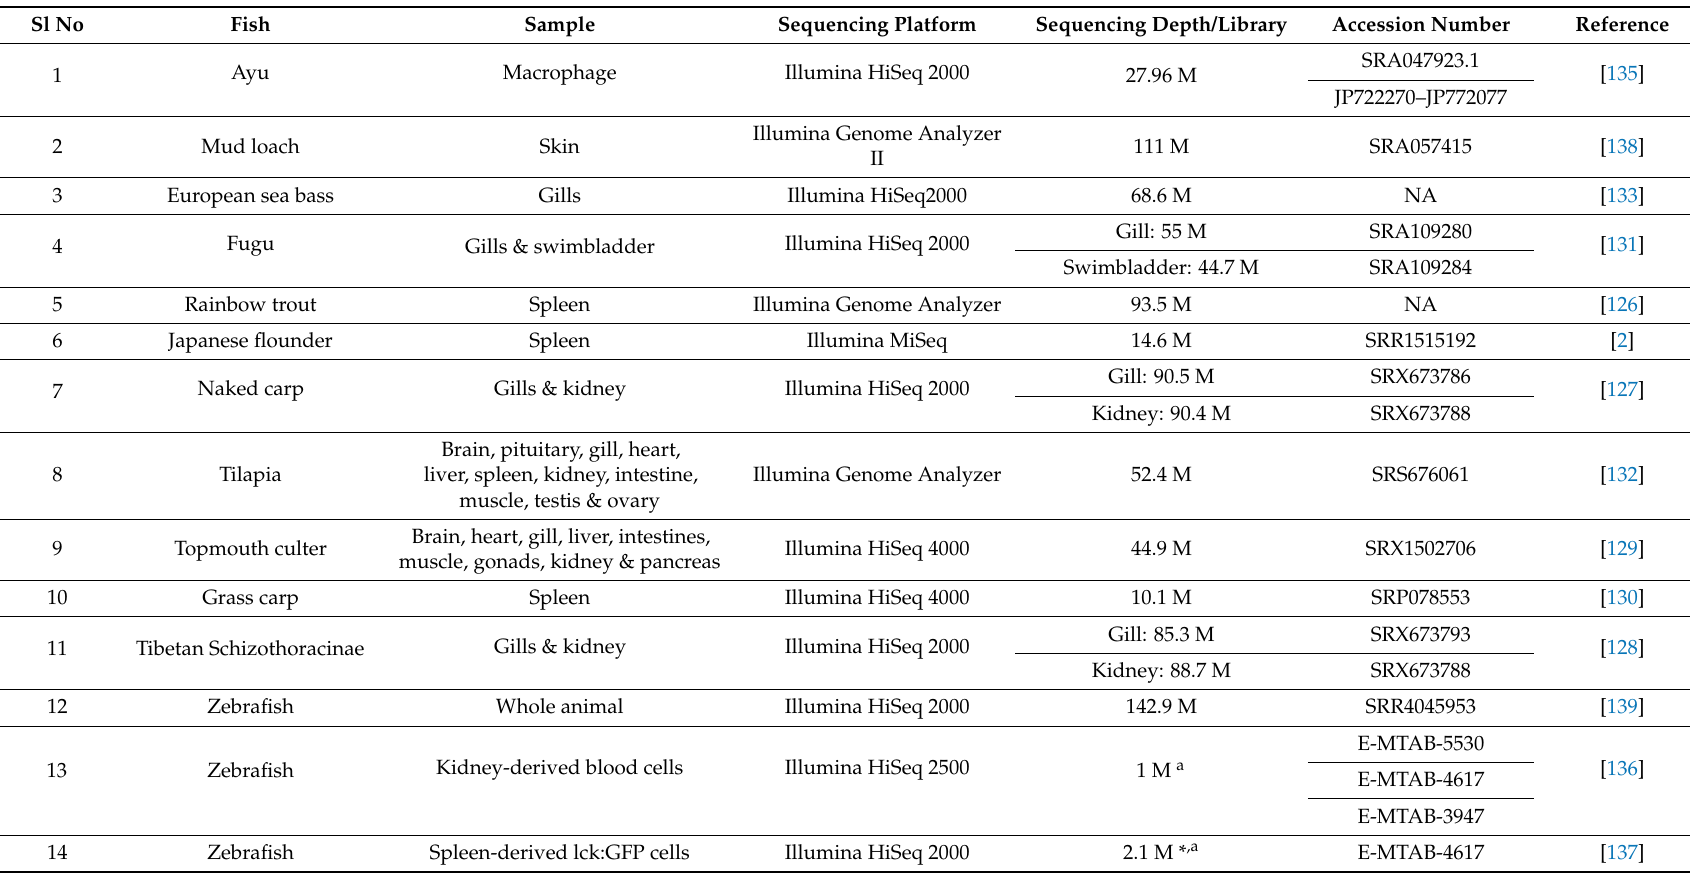
Table 4. RNA-Seq analysis of various fish species. This table shows a list of studies based on transcriptome analyses to understand the immune system and its evolutionary significance in healthy